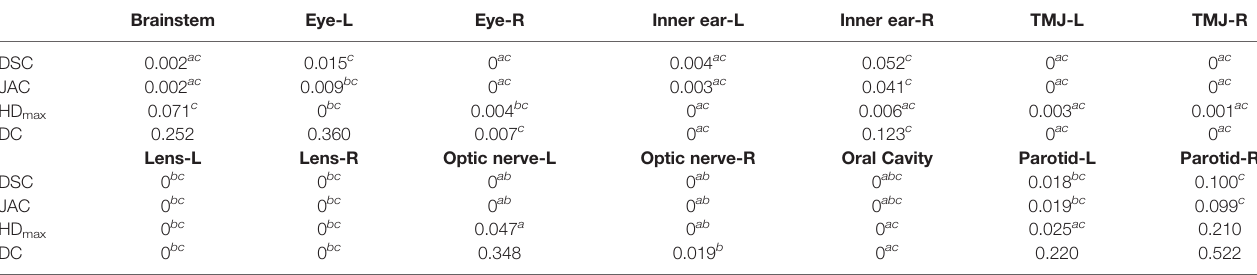
Each symbol represents signi fi cant differences between different groups (p < 0.05). a Indicates a signi fi cant difference between V DL-trained and V DL-pre-built . b Indicates a signi fi cant difference between V DL-trained and V atlas . c Indicates a signi fi cant difference between V DL-pre-built and V atlas